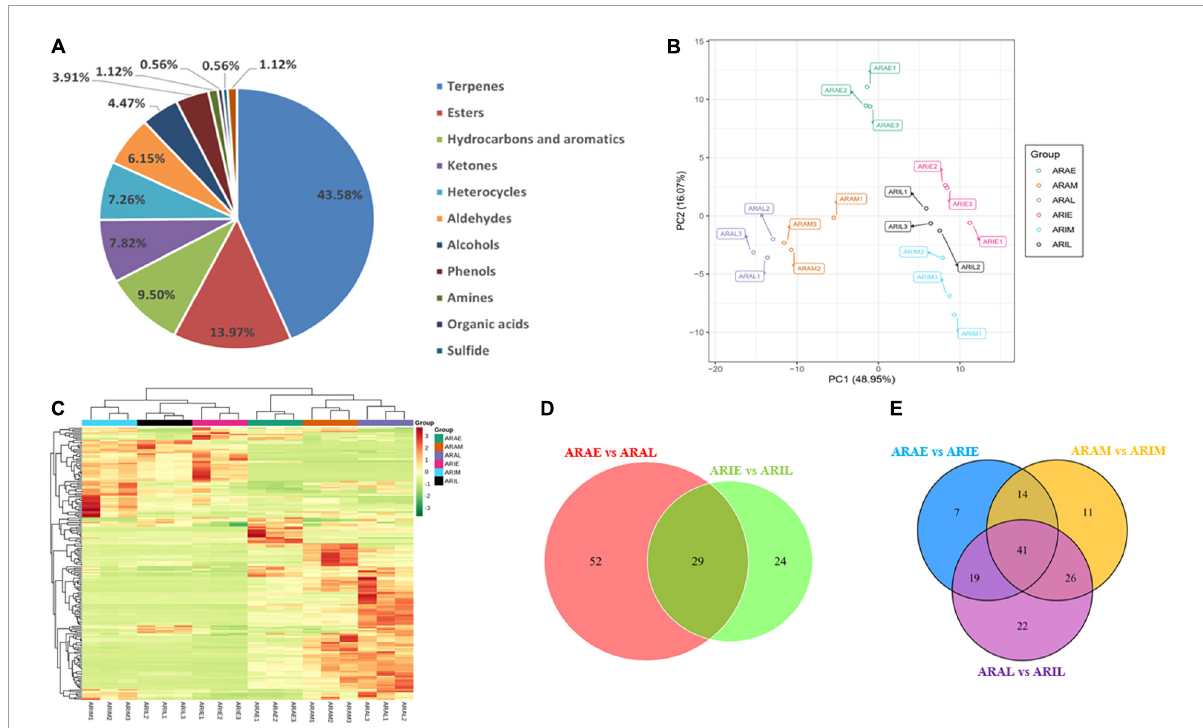
FIGURE6 Differential volatile metabolites analysis. (A) Volatile compounds identified by GC-MS. (B) PCA of volatile metabolites. (C) Hierarchical cluster analysis of volatile metabolites. (D,E) Venn diagrams of A. argyi and A. indica in different growth